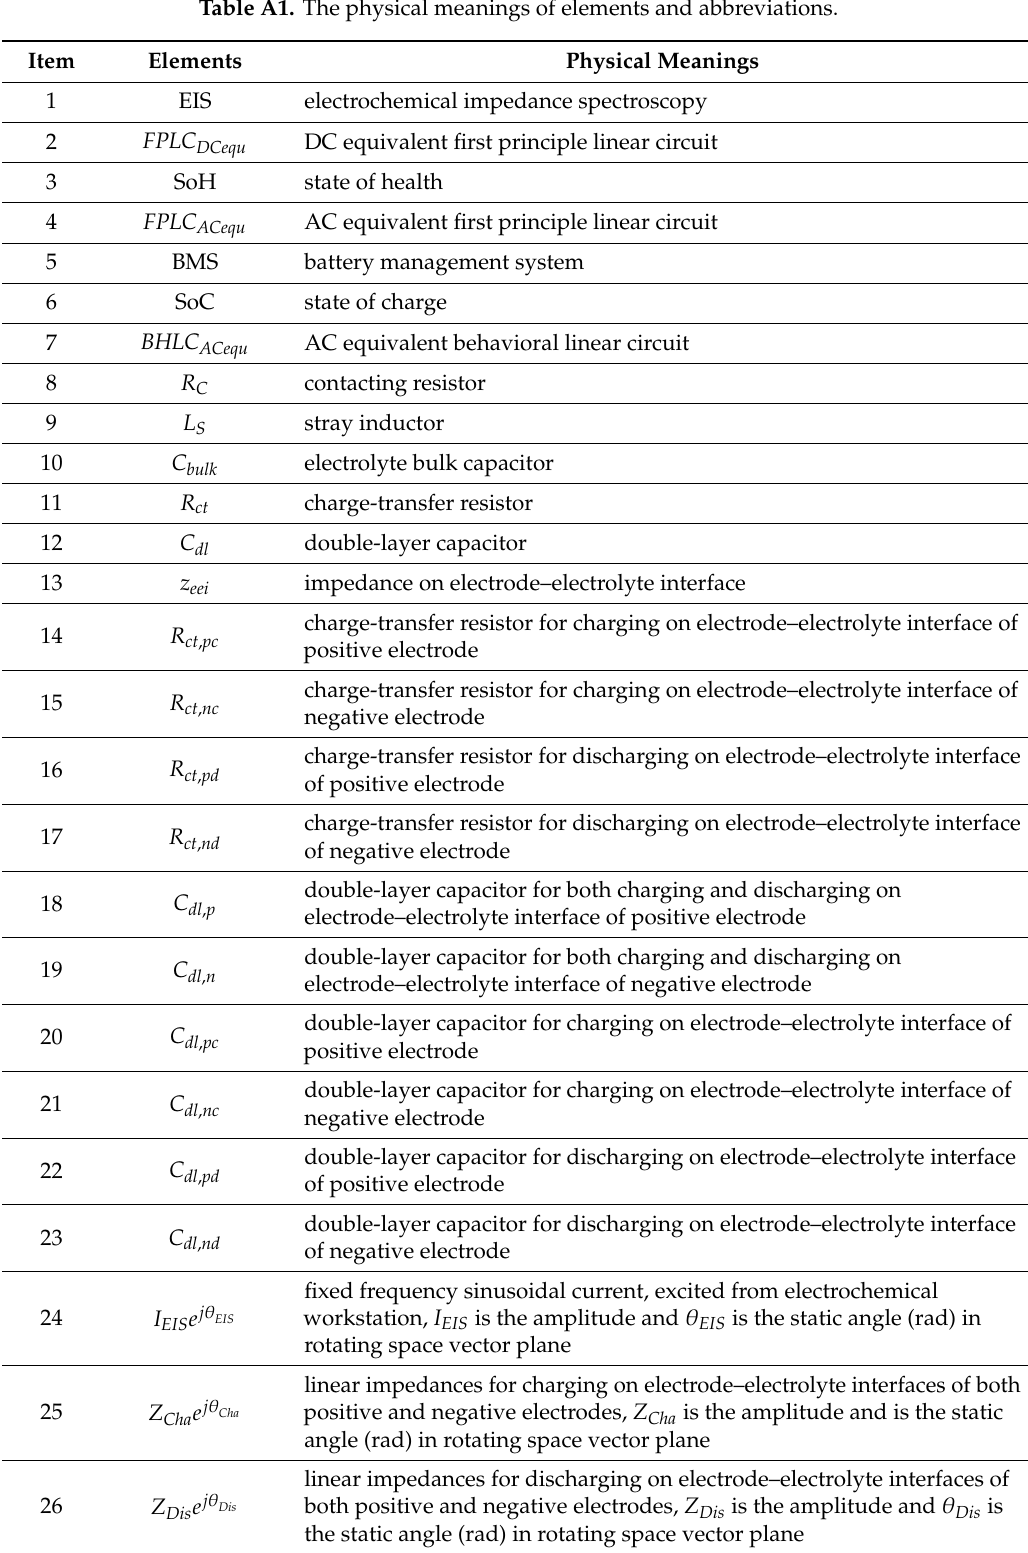
Table A1. The physical meanings of elements and